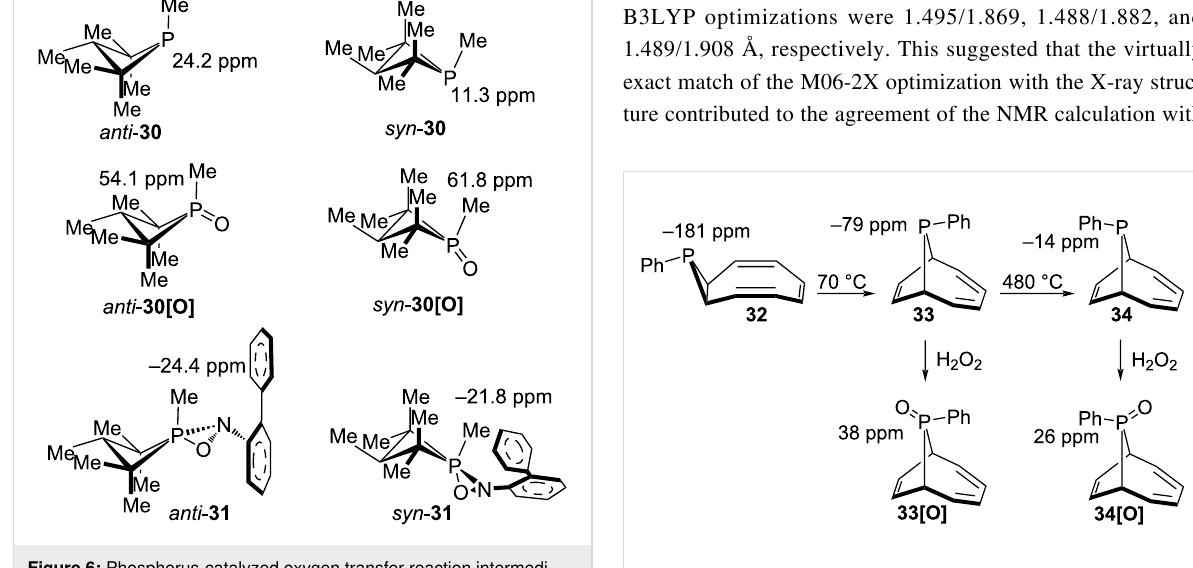
Figure 6: Phosphorus-catalyzed oxygen transfer reaction intermedi- ates. Figure 7: Phosphirane